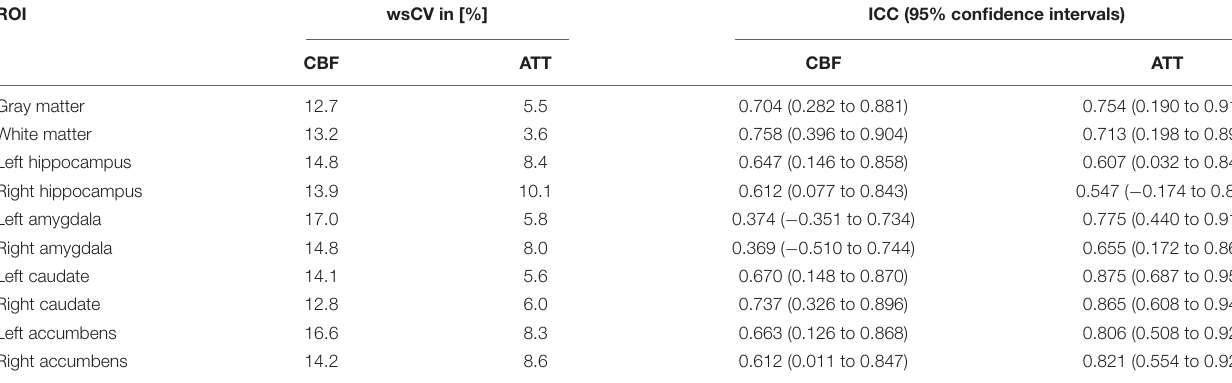
TABLE 3 | Reproducibility of perfusion measures from pseudo-continuous ASL (pCASL) acquisitions. ROI wsCV in [%] ICC (95% confidence intervals) CBF ATT